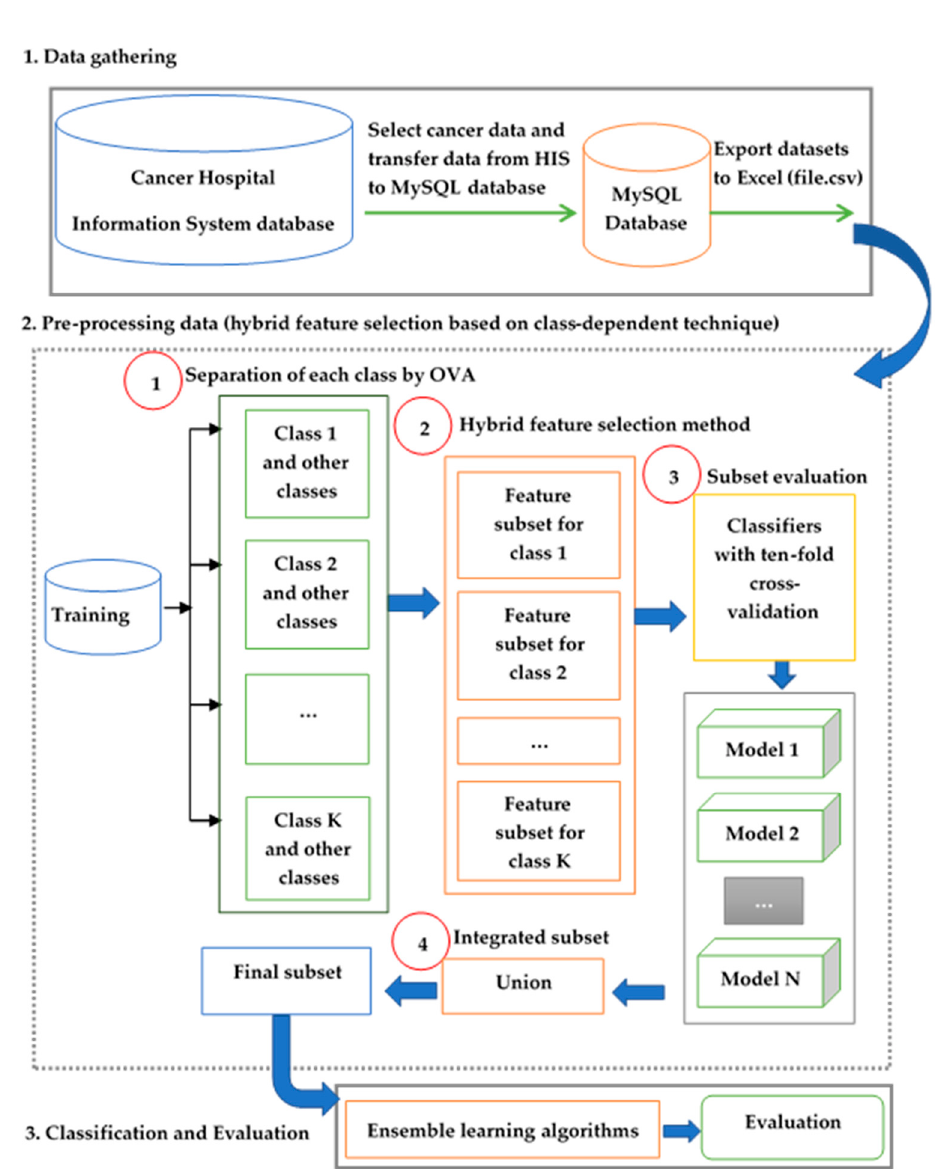
Figure 4. Framework of the hybrid feature selection method based on the class-dependent technique.